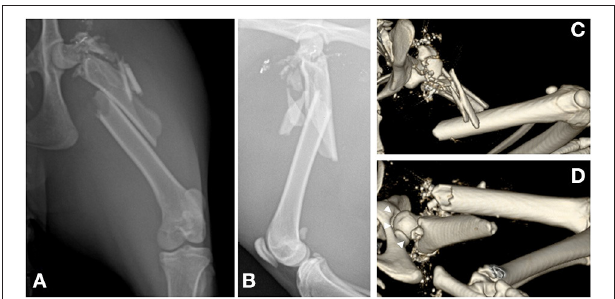
FIGURE 1 | Preoperative radiographs and computed tomography scan of the left hind limb. (A,B) Craniocaudal (A) and mediolateral (B) radiographic views showing highly comminuted fractures at the proximal femur, including the neck, trochanteric, subtrochanteric, and the proximal half of the diaphysis. (C,D) Volume-rendered computed tomography scan of the cranial (C) and caudoventral (D) views showing the comminuted bones of the neck and trochanter and the comminuted spiral fracture of the proximal half of the femoral diaphysis. The hip joint is confirmed to be intact (white arrowheads).